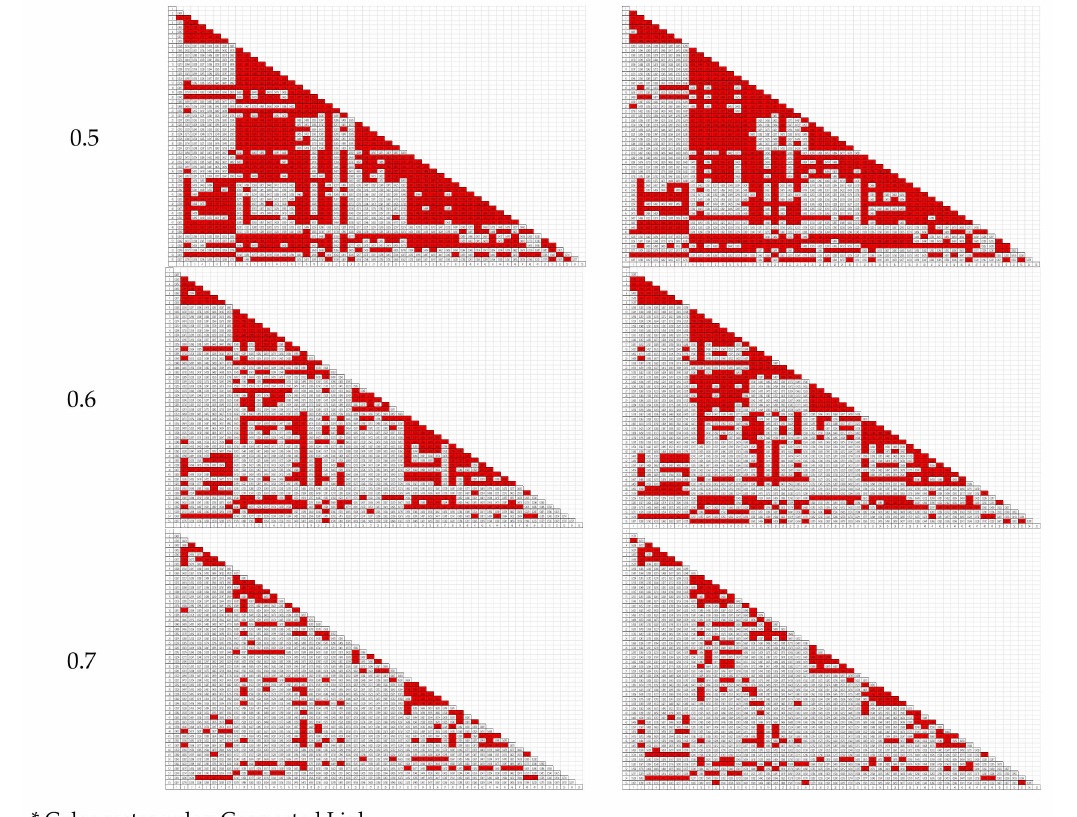
Figure 5. Selection of links according to threshold: the mutual information and Pearson coe ffi cient between stations are calculated as links. According to the threshold, the values, which is bigger than threshold, are filled with red color and the others remain as white